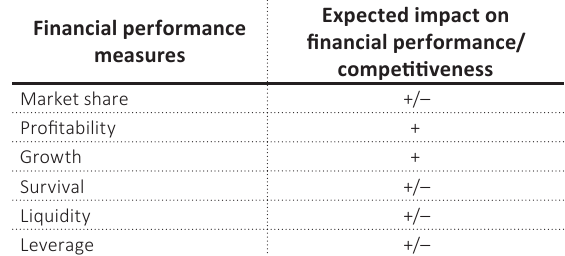
Table 1. Expected impact of financial areas on competitiveness